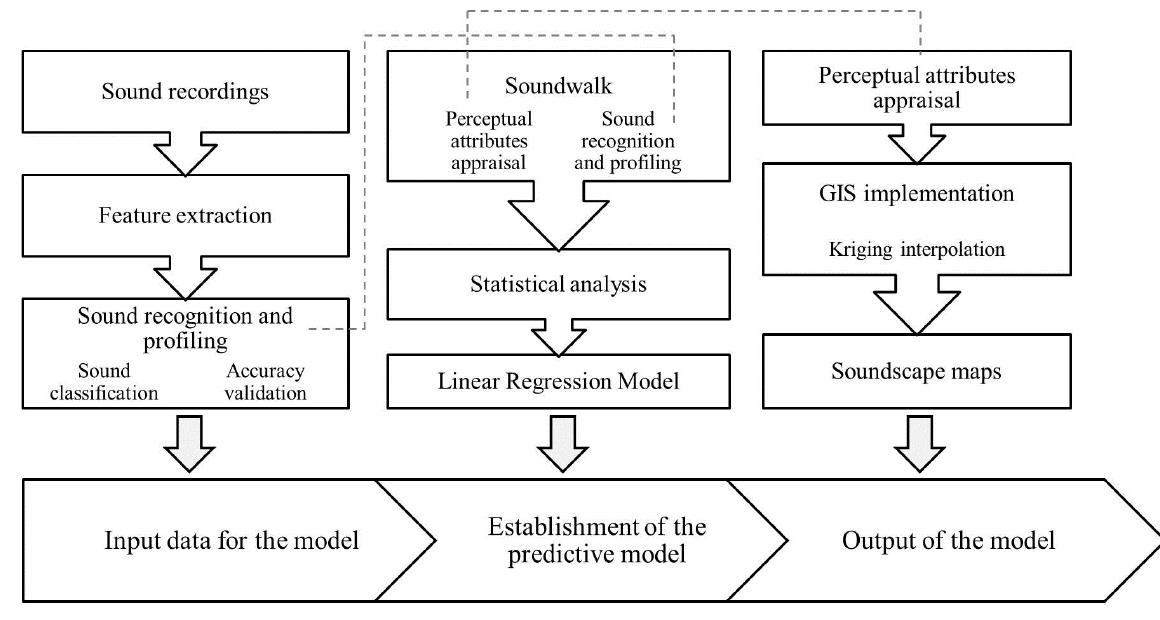
Figure 1: Flowchart of the proposed model for implementing soundscape mapping in smart cities